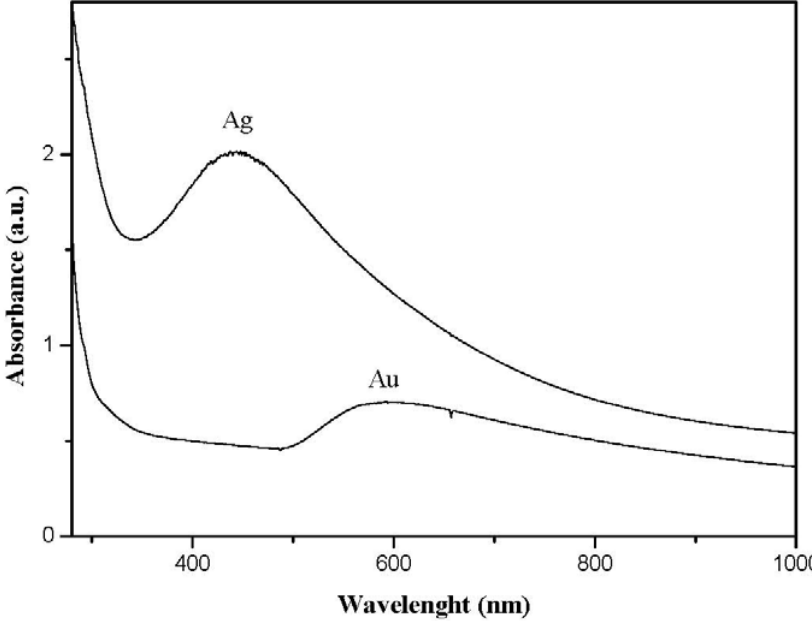
Figure 3. UV-Vis spectra of polystyrene-embedded gold and silver clusters. The characteristic surface plasmon absorptions of silver at 430 nm and of gold at 590 nm reveal the metal formation on a nano-sized